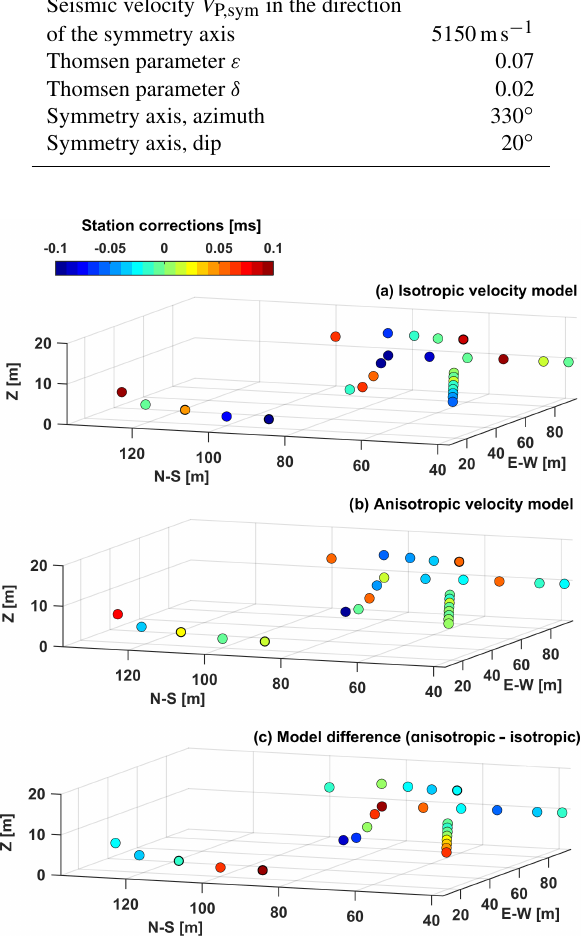
Figure 4. Sensor distribution and corresponding station corrections. (a) Station correction for an isotropic velocity model. (b) Station corrections for an anisotropic velocity model. (c) Difference be- tween station corrections of the two velocity models. It shows the part of the station corrections using an isotropic velocity model that compensates for neglecting